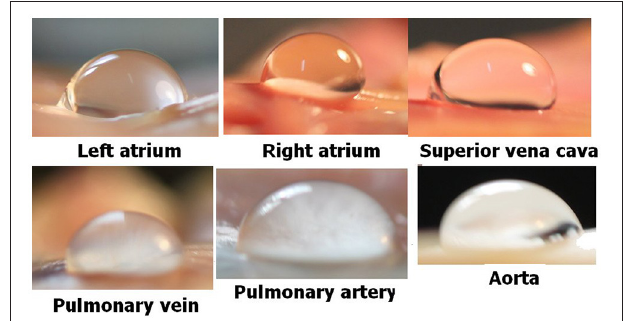
FIGURE 3 | Phospholipids on the capillary. Electron microscope of the luminal aspect of a cerebral capillary from a sheep. An oligolamellar lining of phospholipids can be seen (taken from Hills, 1992 with permission).